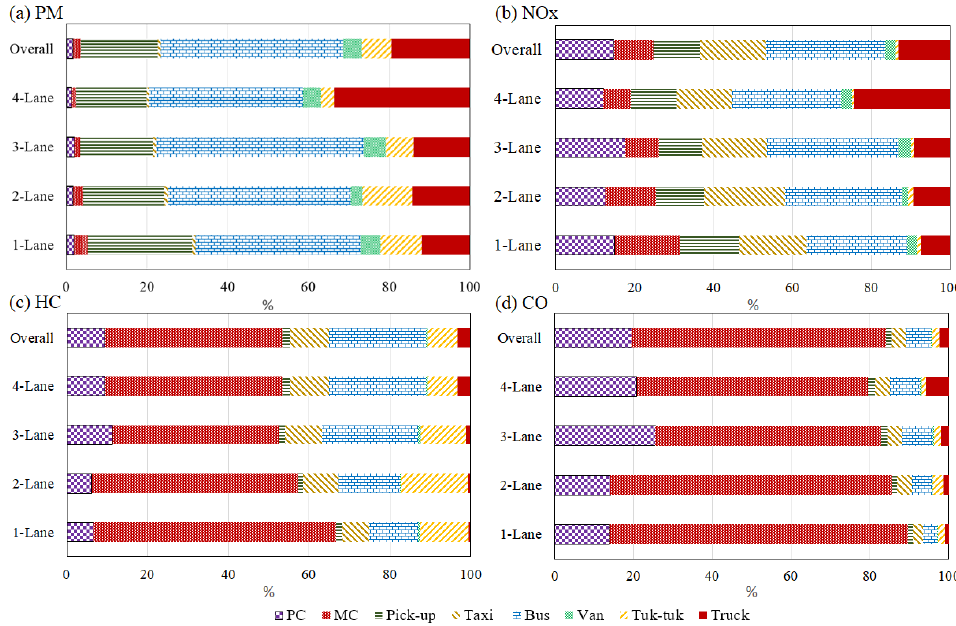
Figure 11. Contribution of different types of vehicles to total emissions in Bangkok ( a ) PM; ( b ) NOx; ( c ) HC; ( d ) CO .